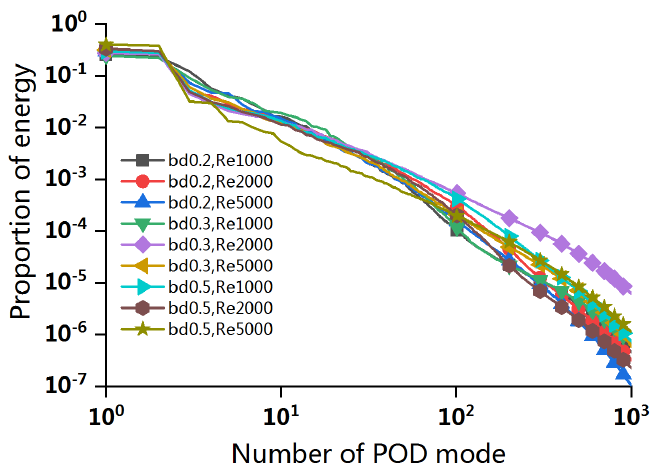
Figure 9. Energy distribution of the POD modes.